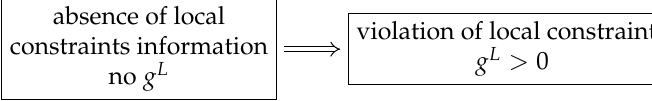
Figure 18. Undetected local constraint violations.